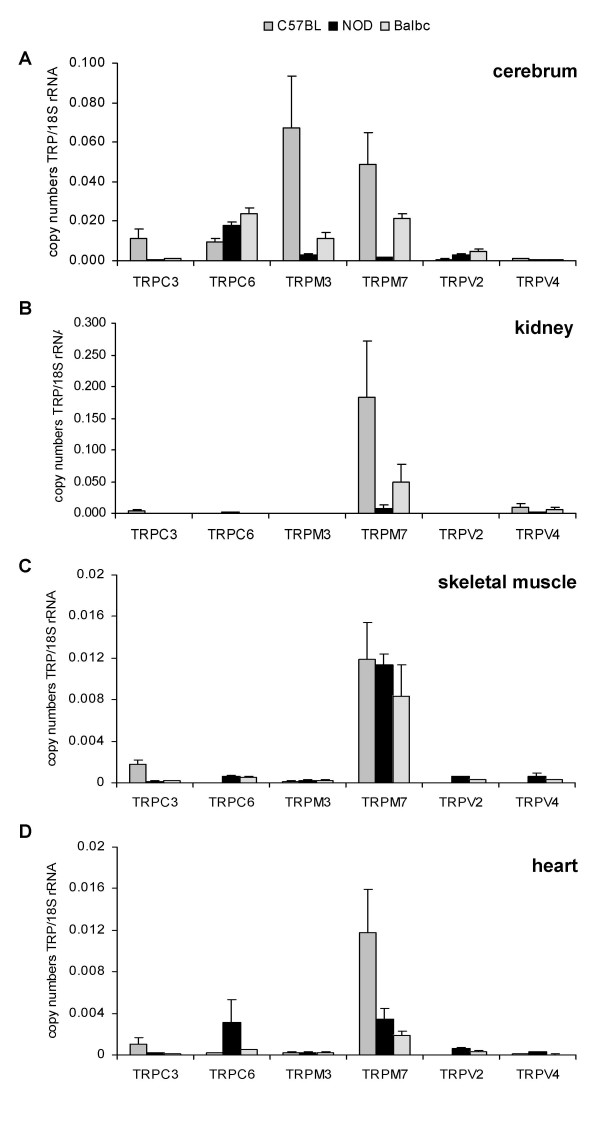
Comparison of TRP channel mRNA levels in different mouse strains. Expression of TRPC3, C6, M3, M7, V2 and V4 channels was determined by Real-time RT-PCR in selected tissues of three different mouse strains. Tissue samples were collected from adult (100 d) C57Bl/10SC (grey columns), NOD (black columns) and Balb/c mice (dotted columns). The mRNA levels of TRP channels are given in relation to 18S rRNA for cerebrum (A), kidney (B) skeletal muscle (C) and heart (D). Means ± S.E.M. are given in all cases for n = 3–10 samples.